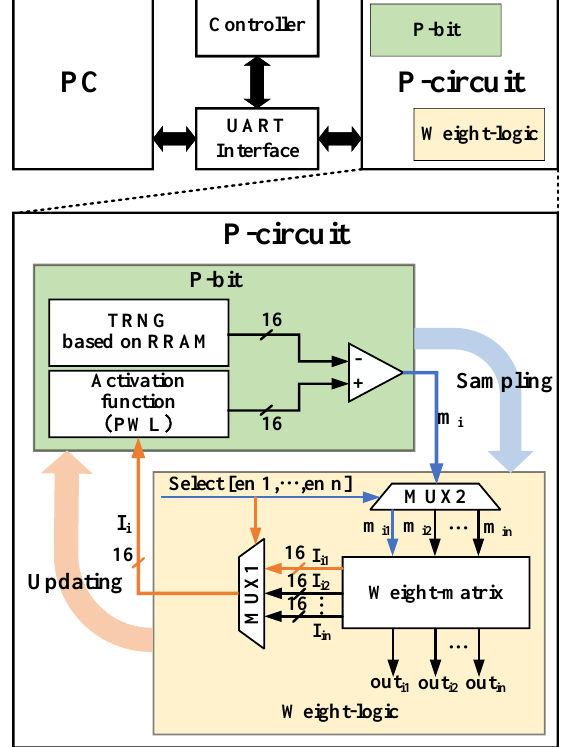
Figure 1. Block diagram of a probabilistic computing system including p-circuit, UART interface, PC, and controller (top). Detailed p-circuit structure (bottom): P-bit (green), weight-logic (yellow).